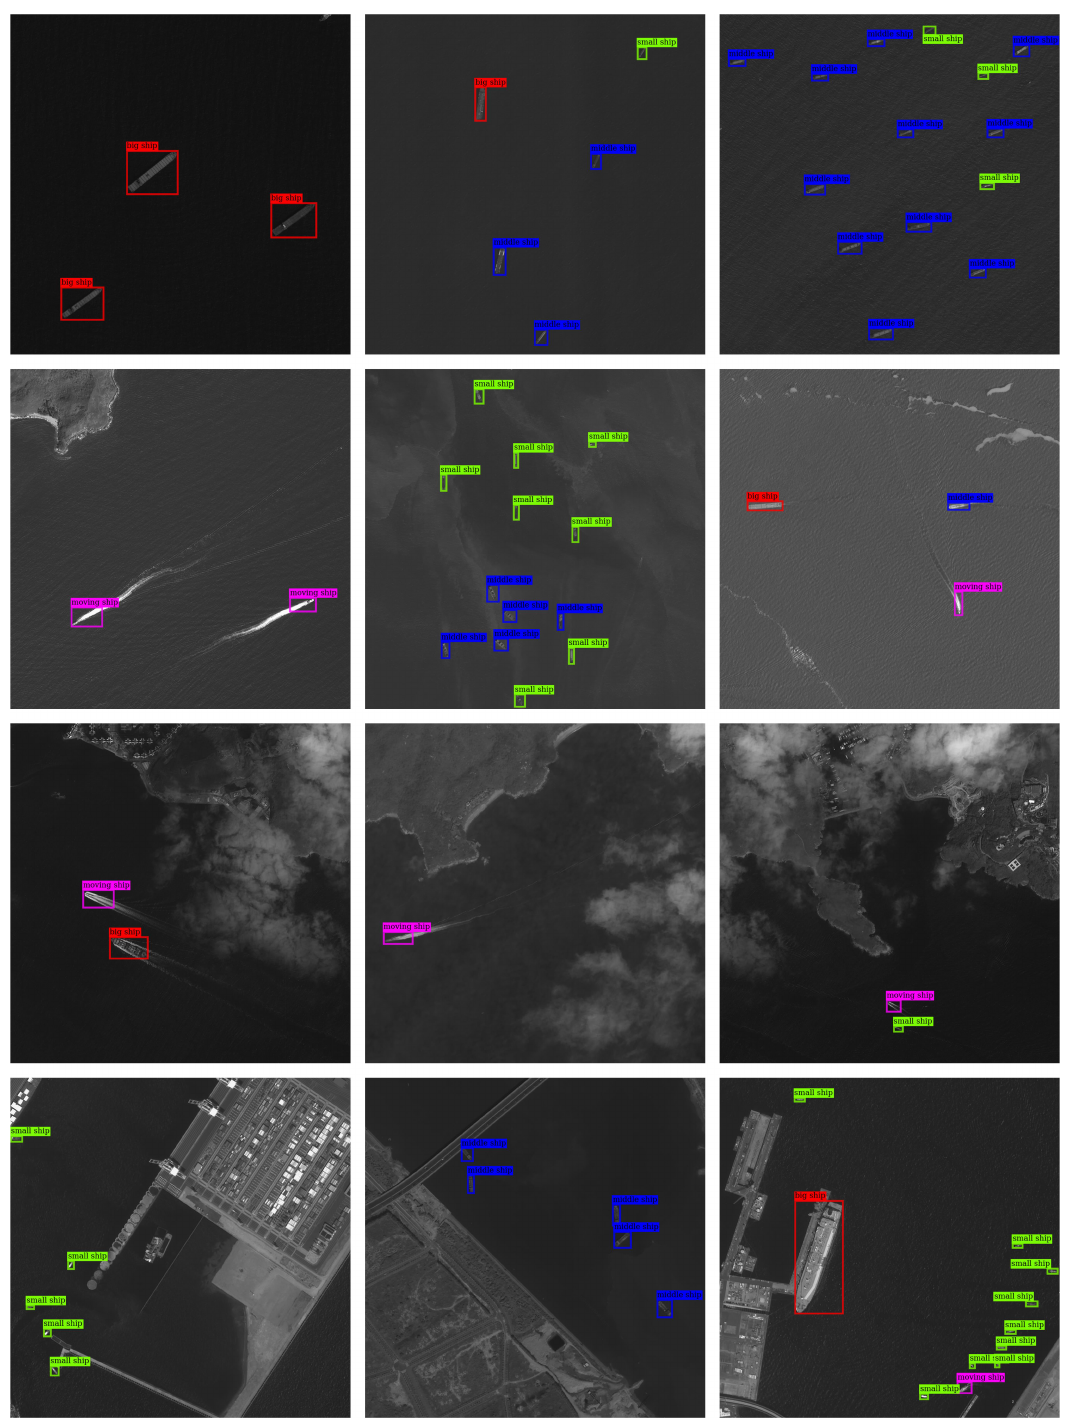
Figure 9. Ship detection results of our ImYOLOv3 in some typical